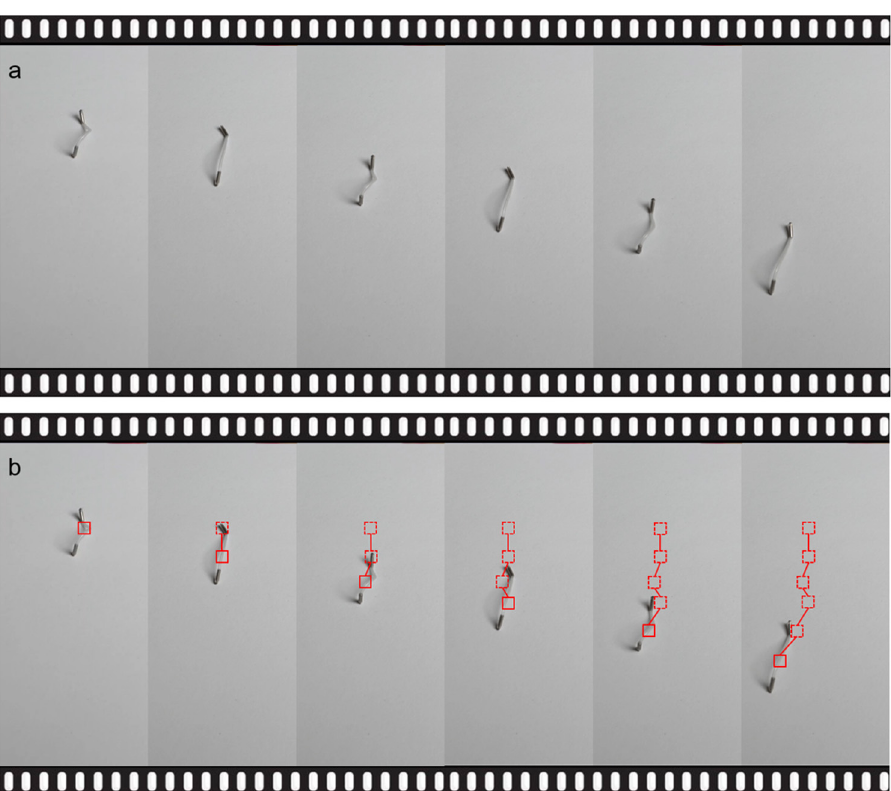
Figure 9. The worm-like motion and path of MHCMM. ( a ) By changing the distance of the external permanent magnet, the MHCMM with opposite magnet polarity at the end can perform a worm-like motion. ( b ) The path of worm-like motion of the MHCMM is